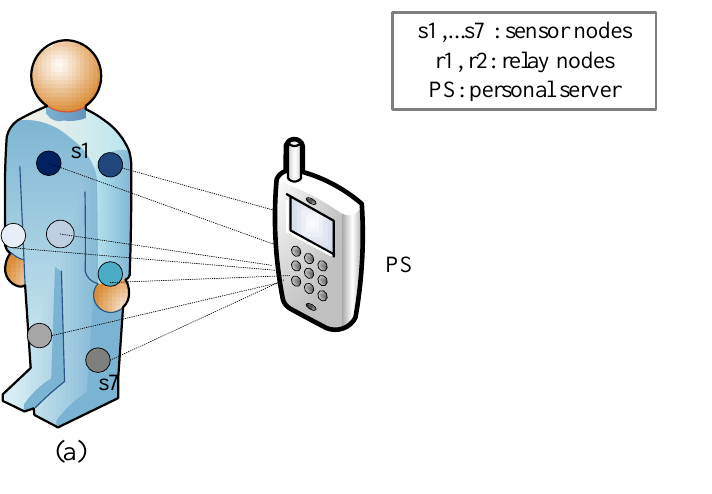
Figure 2. Wearable health monitoring system architecture: ( a ) Flat architecture of BAN, ( b ) Hierarchical architecture of BAN.